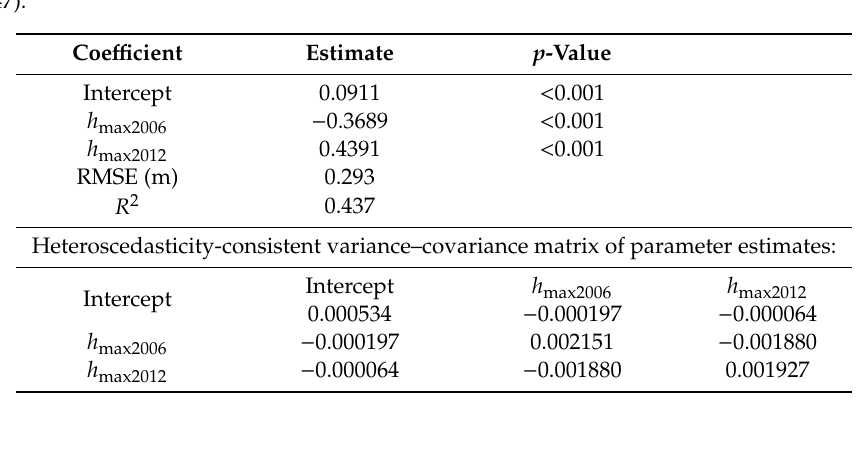
Table 2. Estimation results for linear regression model for height change fitted according to Equation (1) ( n =